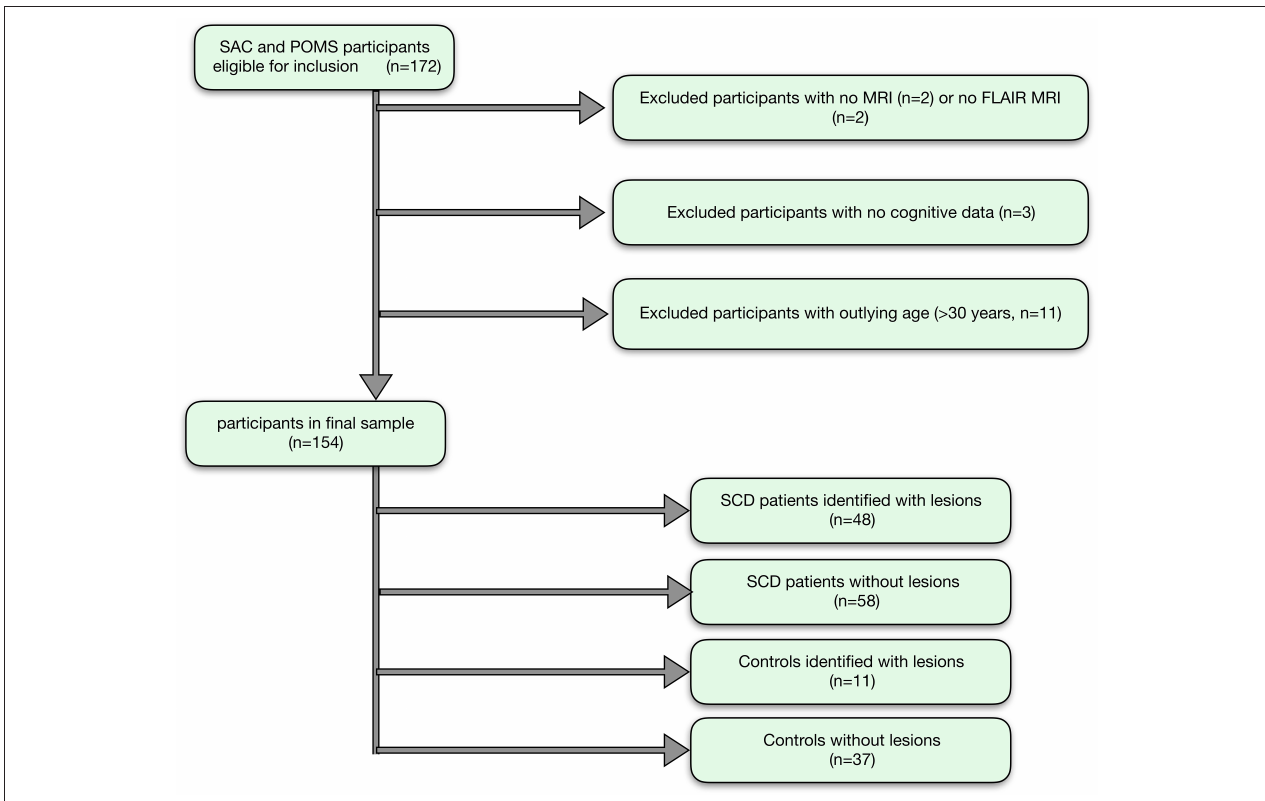
FIGURE 3 | Participant flow-chart. Showing the flow of participants, with reasons for exclusion, and the final groups for analysis.